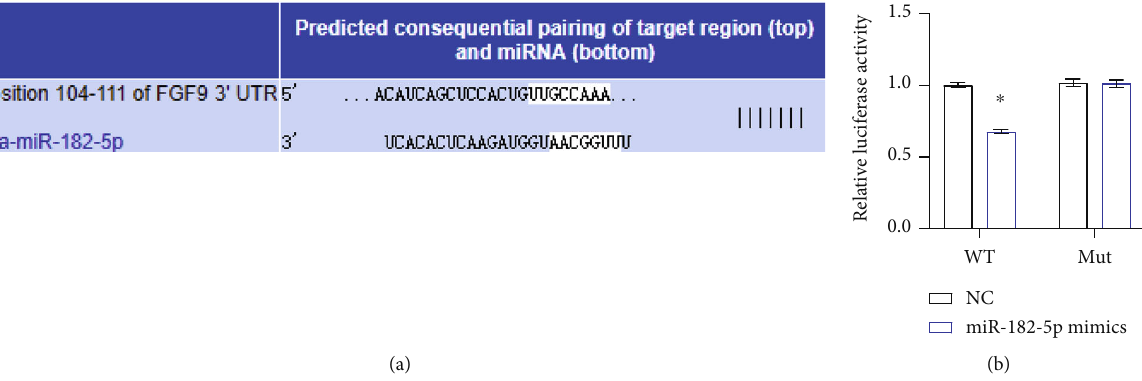
Figure 4: miR-182-5p was targeted to FGF9. (a) Targetscan revealed the binding sites of miR-182-5p and FGF9. (b) The targeting relationship of miR-182-5p and FGF9. * P < 0 : 05 vs. NC